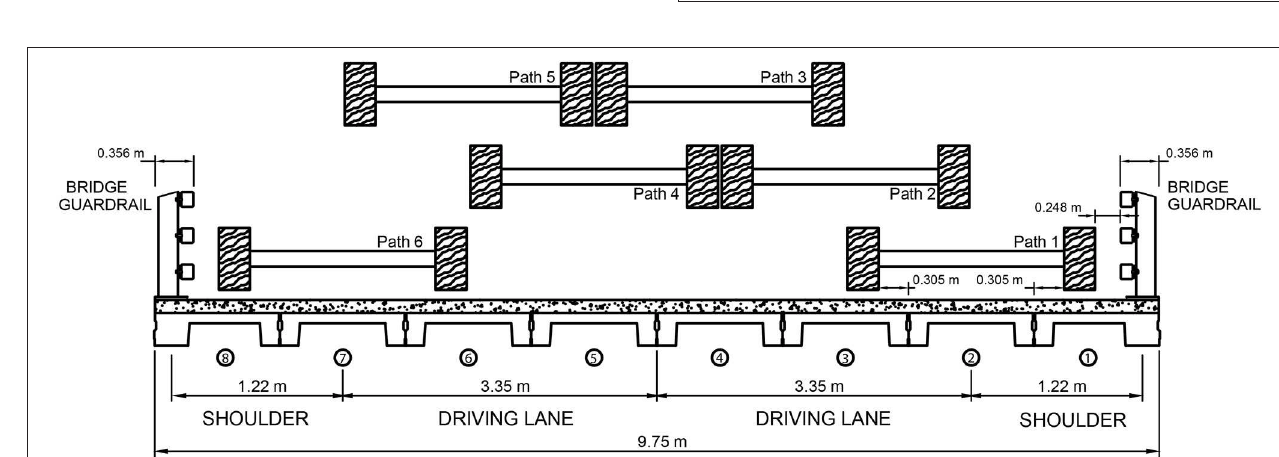
FIGURE 4 | Single truck transverse load paths 1 through 6 (truck centered on girder centerline).